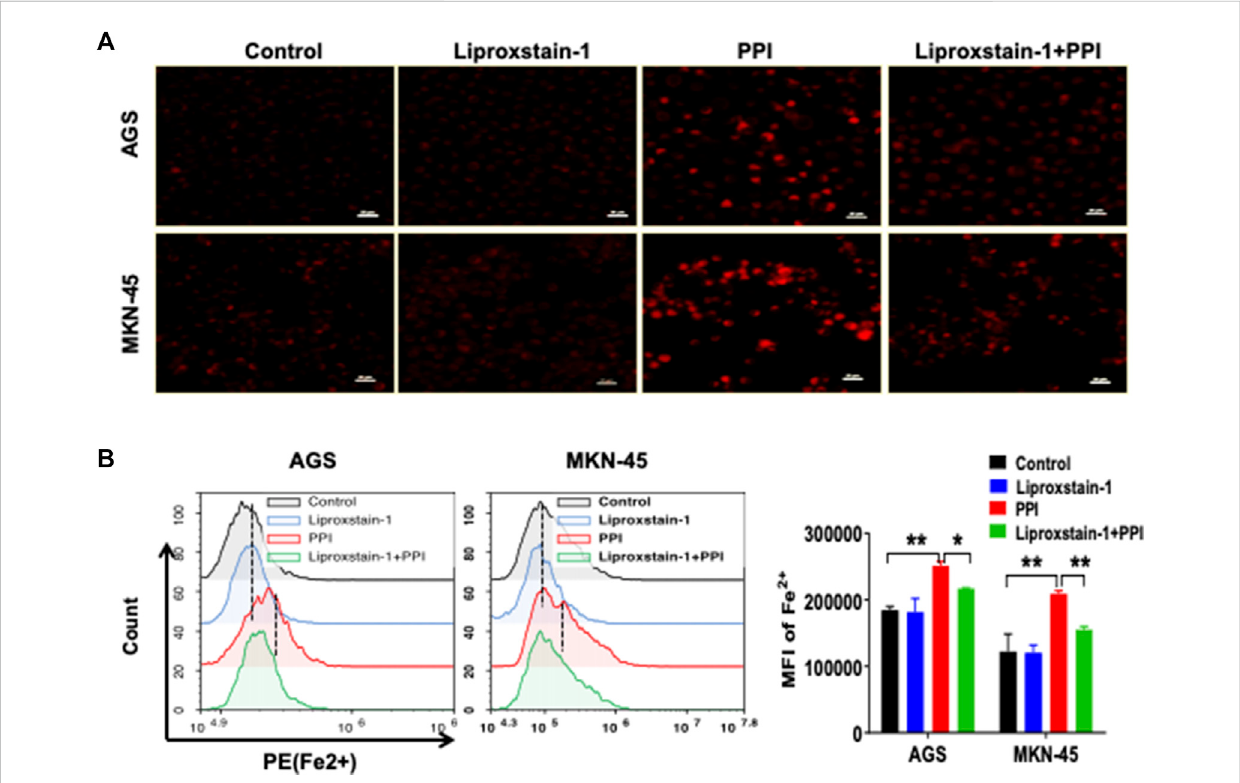
FIGURE 4 Aferroptosisinhibitorisalso con fi rmedtoblock PPI-induced accumulation ofFe2+ingastriccancer cells. AGSand MKN-45cells weretreatedwith liproxstain-1 and/or PPI as described in Figure 3. They were then labeled with FerroOrange fl uorescent probes to detect intracellular ferrous (Fe2+) concentrations through fl uorescence microscopy (A) and fl ow cytometry (B) . Scale bars = 50 µm. Data are shown as mean ± SD while p values were determined using one-way ANOVA (* p < 0.05, ** p <